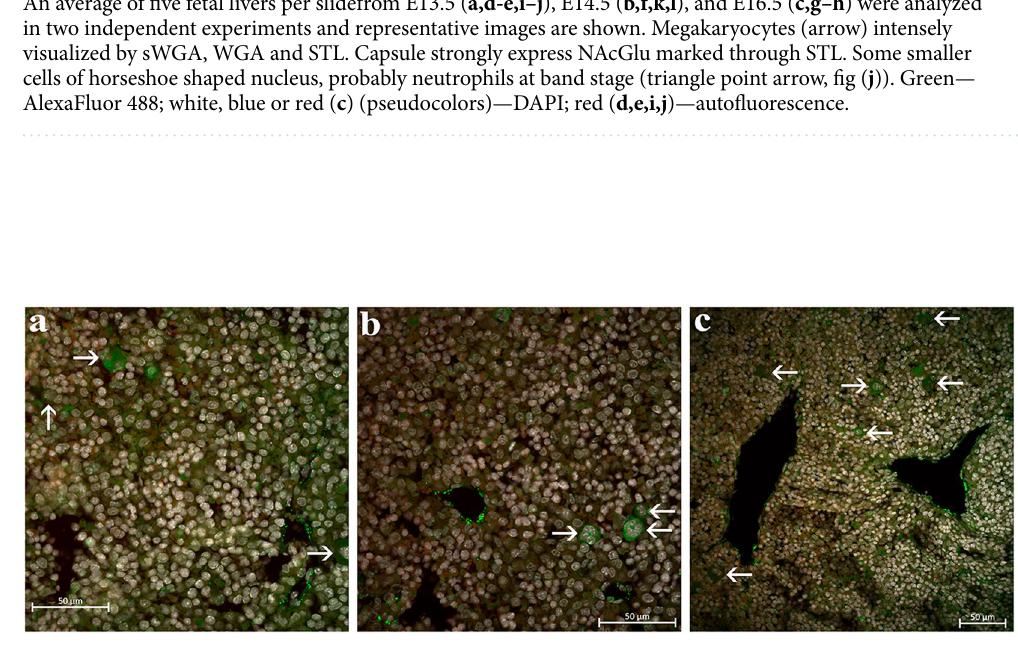
Figure 4. vWF expression at five fetal livers from E14.5.Two independent experiments were carried out and representative images are shown. Dotted expression in endothelial cells from portal vessels and different intensities inside from smaller to large size megakaryocytes (arrow). Green – AlexaFluor 488; white –